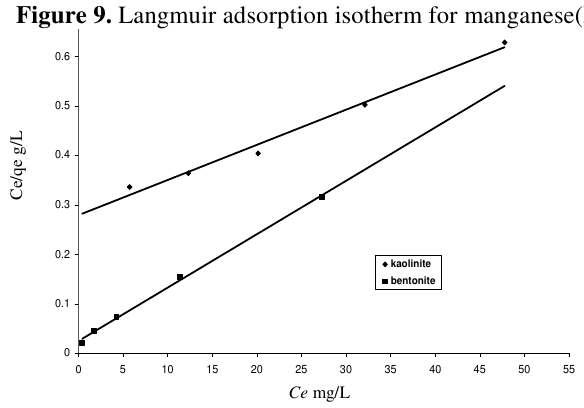
Figure 10. Langmuir adsorption isotherm for